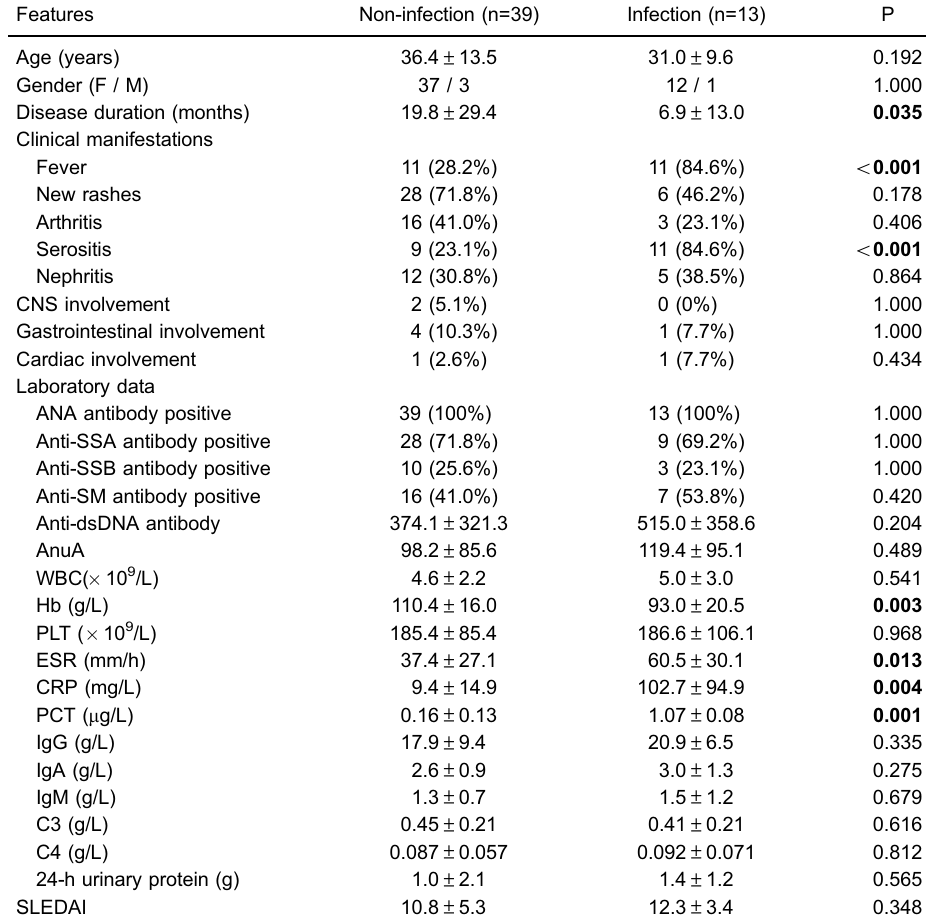
Table 1. Characteristics of untreated systemic lupus erythematosus (SLE) patients with and without infection.